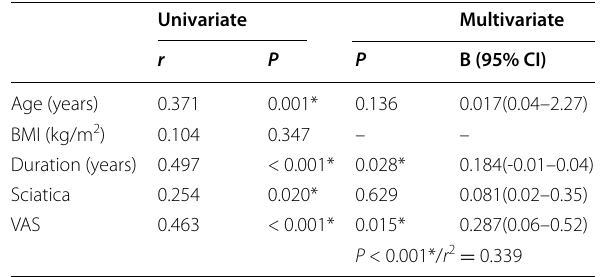
B: Unstandardized coefficients, r: Pearson coefficient, R 2 Coefficient of determination CI confidence interval